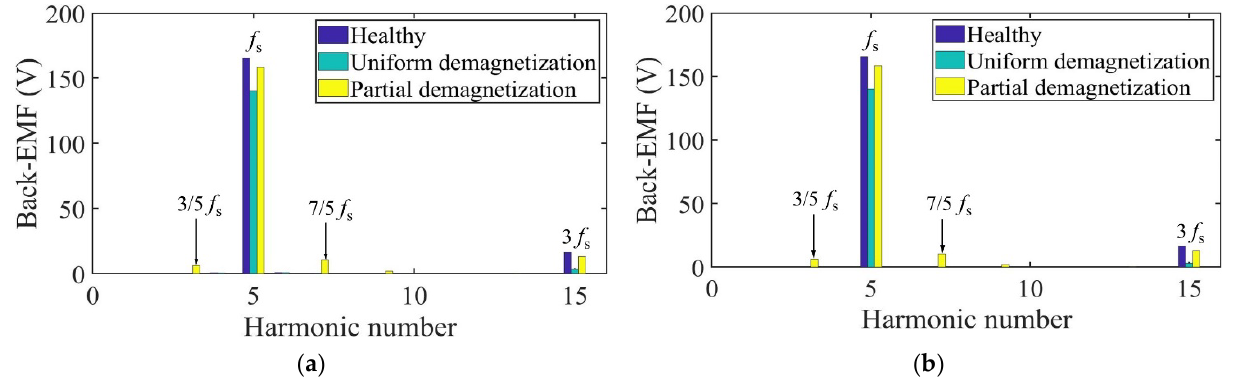
Figure 13. Harmonics in the back-EMF relative to fundamental wave at fs = 166.67 Hz. ( a ) Analytical model; ( b ) FE model.